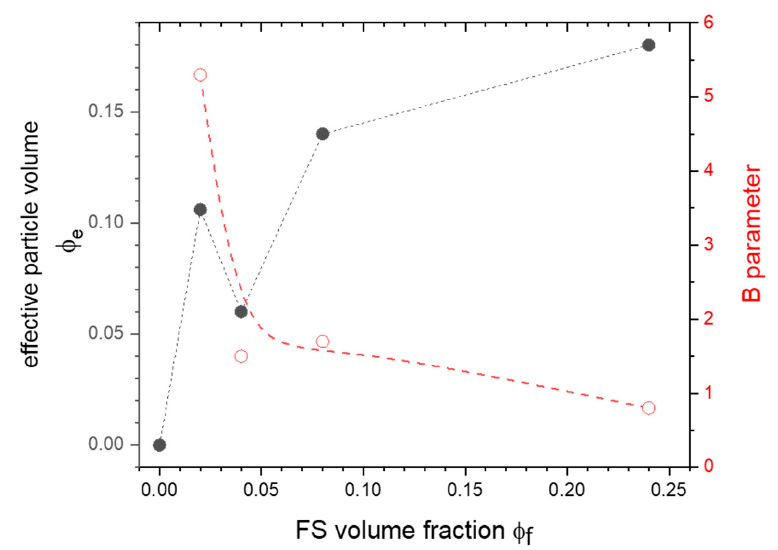
Figure 6. Effective particle volume fraction ( ф e , ● ), and effective volume per single particle (B) as a function of fumed silica volume fraction ( ф f , ○ ), according to the Sumita model [68].